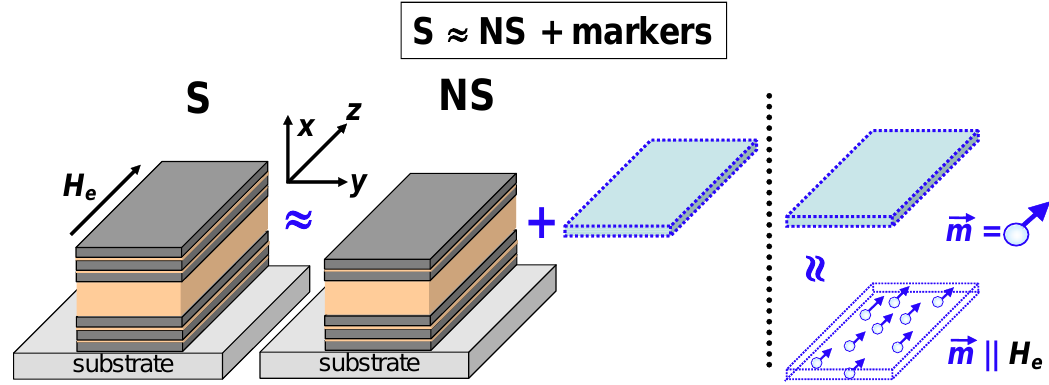
Figure 8. Schematic representation of the symmetric (S) and non-symmetric (NS) MI multilayered sensitive elements. In a model case (to mimic the layer of randomly distributed magnetic markers), the top multilayer can be substituted by a set of superparamagnetic spherical markers with the same → m , oriented in the direction of the applied field, H e individual moments,